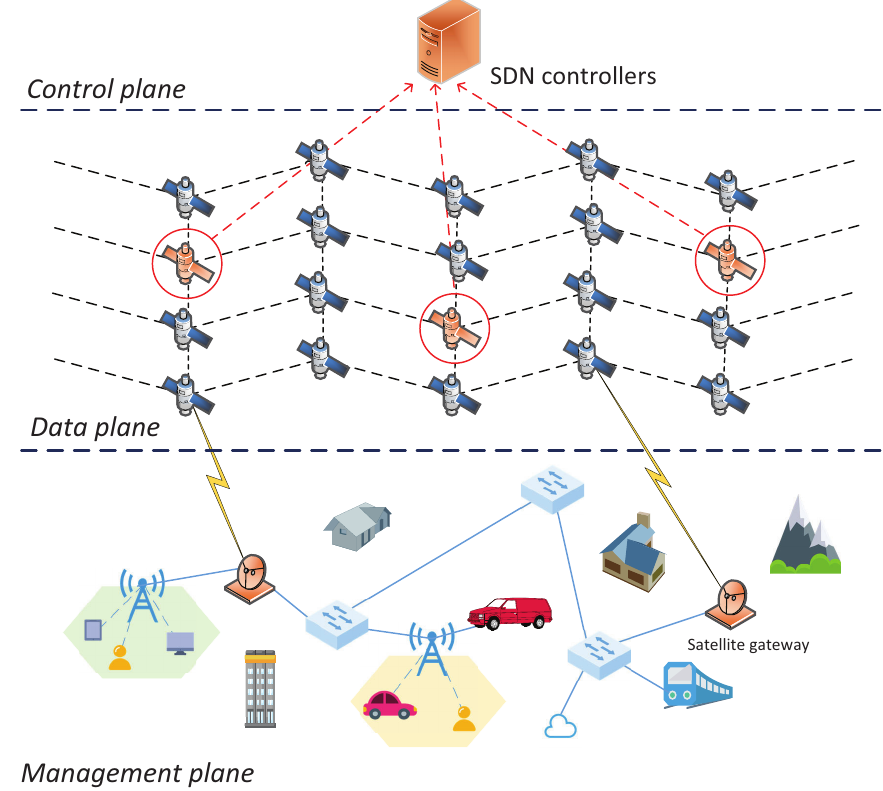
Figure 2. The overview of the software-defined STIN